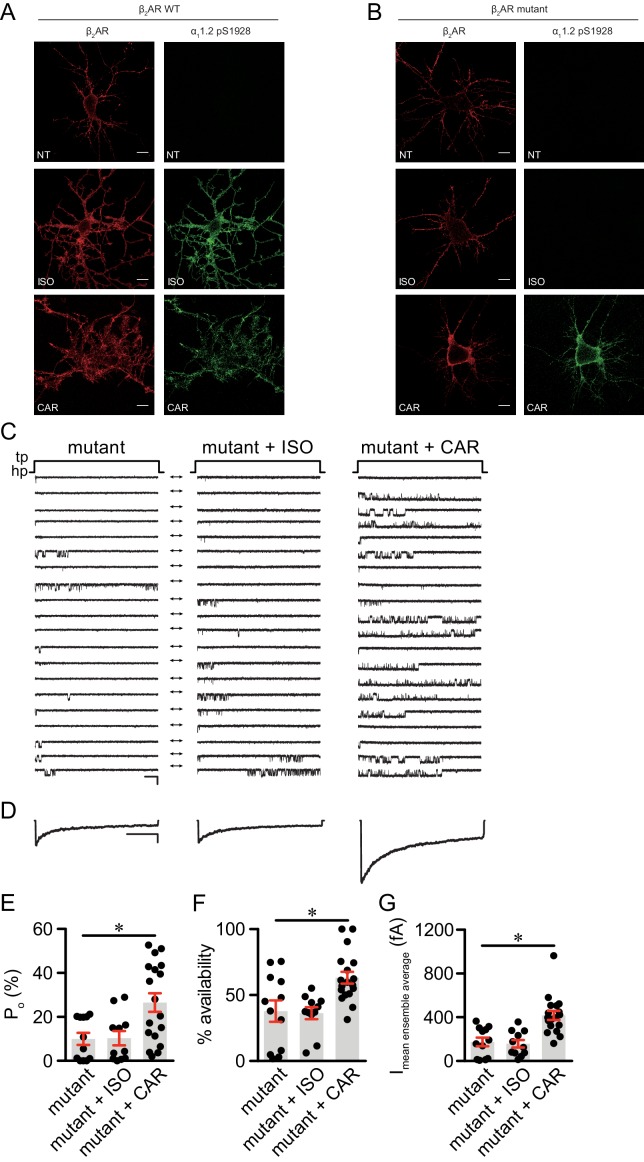
The β2AR mutant selectively supports carvedilol-induced augmentation of LTCC activity in neurons.(A–B) β1AR/β2AR double knockout (DKO) mouse hippocampal neurons on 7–10 days in vitro (DIV) were cotransfected with FLAG-tagged β2AR WT (A) or mutant (B) and HA-tagged LTCC α11.2 subunit, 24 hr later cells were either mock treated (NT), or treated for 5 min with 10 nM isoproterenol (ISO) or carvedilol (CAR), fixed and labeled with anti-FLAG and a phospho-specific antibody for S1928 phosphorylated α11.2. Confocal images show mutant β2AR losts the ability of promoting LTCC phosphorylation upon ISO stimulation but remained the ability upon CAR stimulation in neurons. Scale bar, 10 μm. Representative of 6 images for each condition, three experiments. (C) Representative single channel recordings of LTCC CaV1.2 currents using 110 mM Ba2+ as charge carrier in DKO neurons on 7–10.days DIV expressing mutant β2AR after depolarization from −80 to 0 mV in in control patches (mutant) and patches containing 1 μM isoproterenol (ISO) or 1 μM carvedilol (CAR) in the patch pipette. Shown are 20 consecutive sweeps from representative experiments. Arrows throughout the figure indicate the 0-current level (closed channel). Scale bar denotes 2 pA and 200 ms. (D) Ensemble average currents as determined from all sweeps recorded for all the experimental conditions. Scale bar denotes 50 fA and 400 ms. (E–G) Mean ± s.e.m. for (E) Po (%), (F) availability (i.e. likelihood that a sweep had at least one event) (%) and (G) the mean ensemble average current (fA) for each experimental condition. *p<0.05 with Kruskal Wallis – Dunn’s multiple comparison test. Sweep and n numbers as well as summary statistics are in Supplementary file 2.Figure 7—source data 1.Excel spreadsheet containing the individual numeric values of Po, availability and current analyzed in Figure 7E-G.